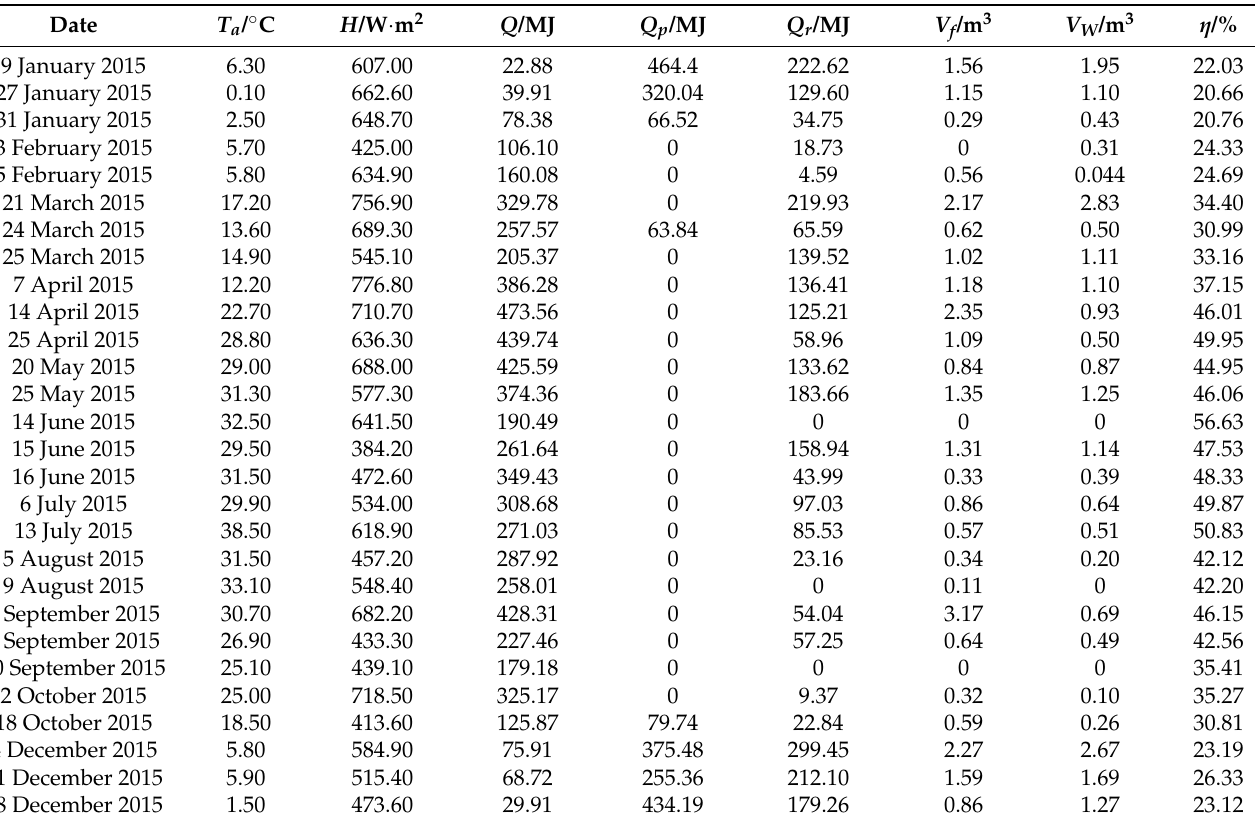
Table 1. Annual operating